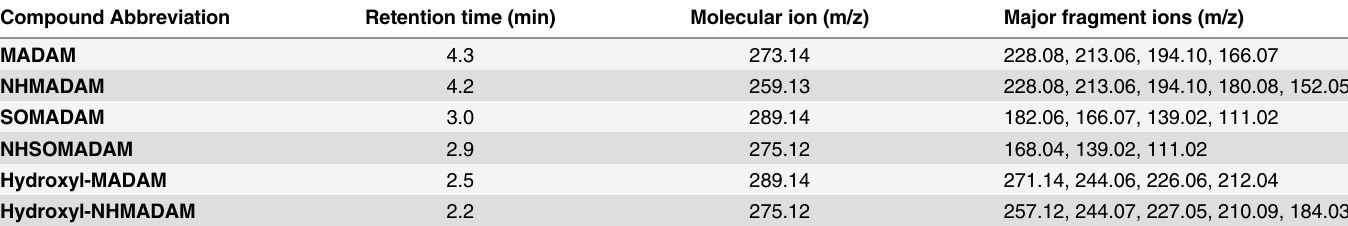
Table 3. List of metabolites identified after incubation of MADAM with RLM (incubation time: 30 min) and HLM (incubation time: 60 min). The reten- tion time, m/z of parent and major fragment ions for each compound are listed. Compound Abbreviation